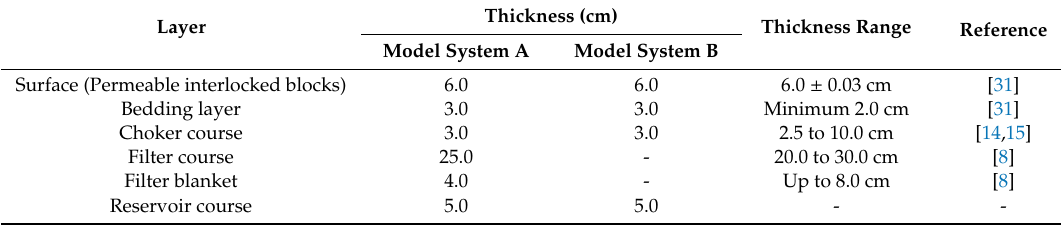
Figure 2. Pavement layers in each model system. ( a ) Model system A; ( b ) Model system B. Table 3. Thickness of the pavement Table 3. Thickness of the pavement layers.